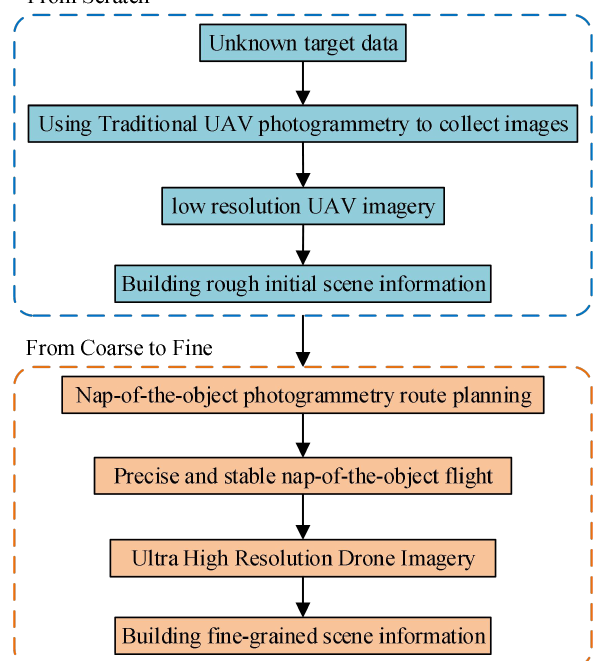
Figure 1 . Automatic collection workflow of high-precision data for nap-of-the-object photogrammetry